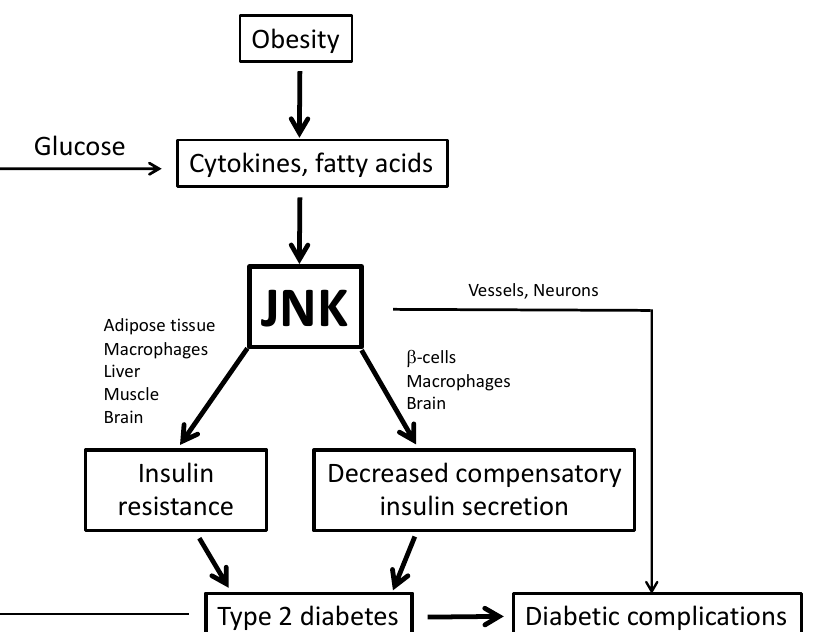
Figure 1. c-Jun N-terminal kinase (JNK) is an inflammatory kinase that is ubiquitously expressed. During obesity, a low-grade chronic inflammatory disease, there are elevated cytokines and free fatty acids, which can activate JNK in various tissues. Activation of JNK is implicated in obesity-induced insulin resistance and decreased compensatory insulin secretion, both of which are key features of type 2 diabetes (T2D). During T2D, there are elevated glucose levels in plasma, which also contribute to the activation of JNK. Activation of JNK is also associated with diabetic complications.